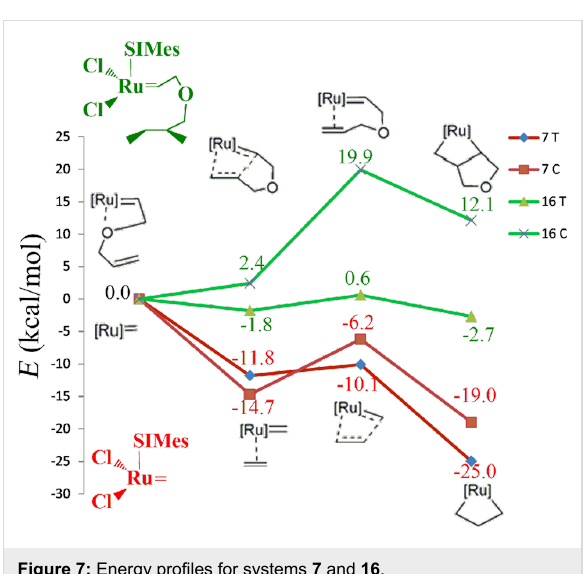
Figure 7: Energy profiles for systems 7 and 16 .